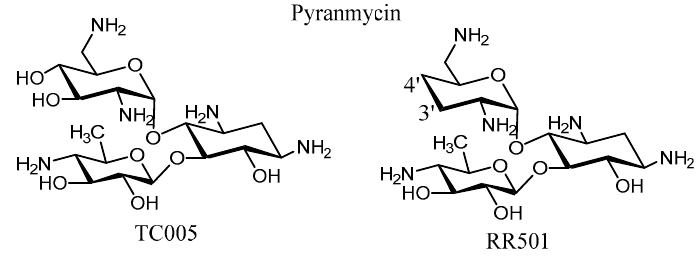
Figure 5. Structure of kanamycin B analogs (Pyranmycin).